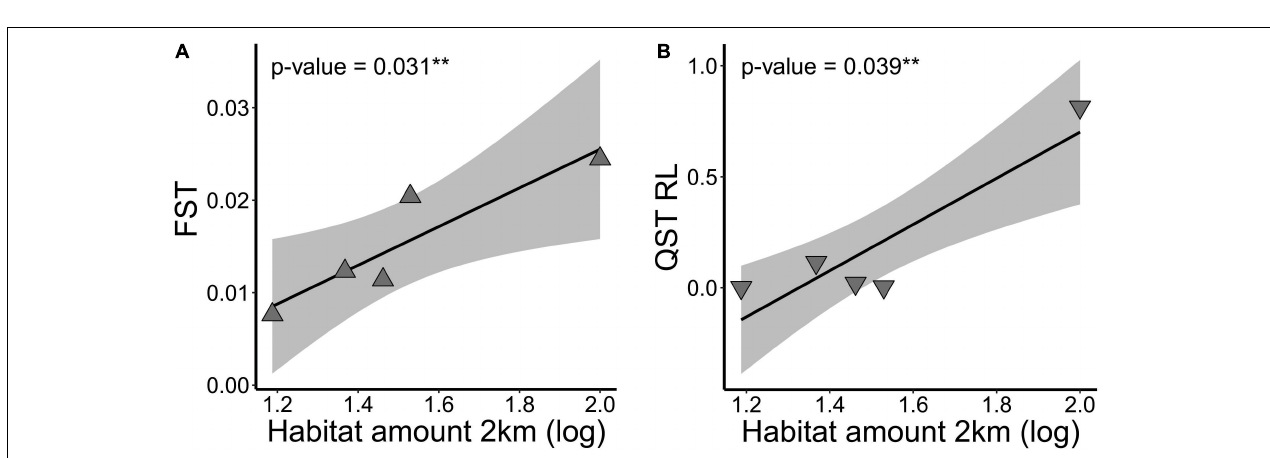
FIGURE 3 | Relationships of neutral genetic variability and habitat amount in five landscapes and 10 sampling sites of Tabebuia aurea in the Brazilian Cerrado. (A) Genetic diversity ( He ). (B) Allelic richness (AR). Black line is the linear regression fit and shaded area is the 95% confidence interval. All fits were significant ( p < 0.05).